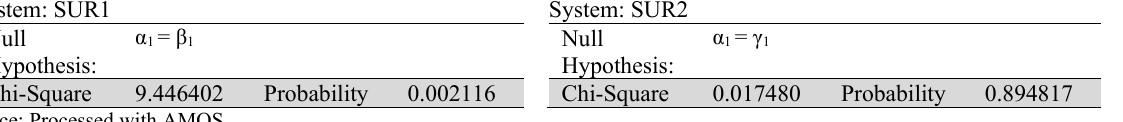
Result Chi-square and Wald